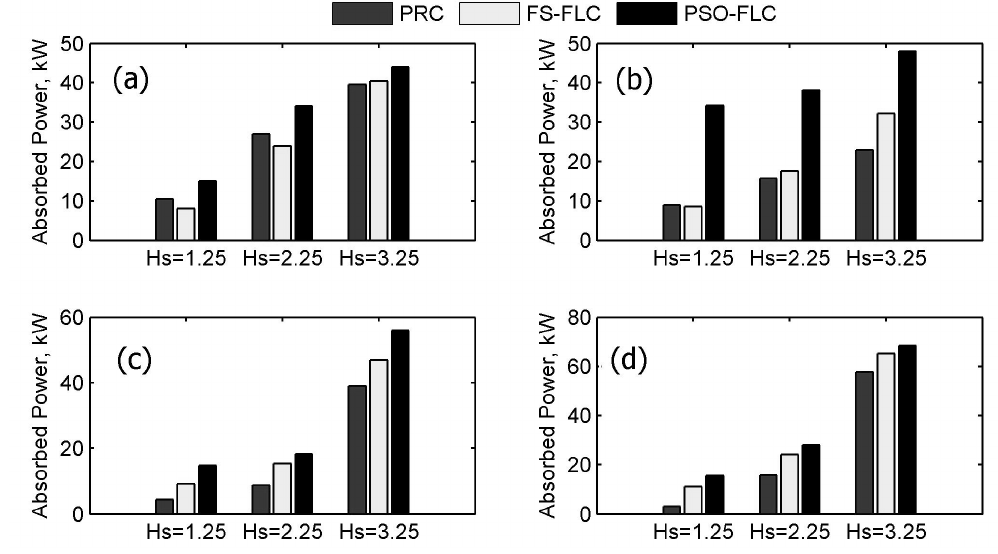
Figure 10. WEC power absorption at different sea-state scenarios ( a ) long period narrow bandwidth; ( b ) long period broad bandwidth; ( c ) short period narrow bandwidth; ( d ) short period broad bandwidth.